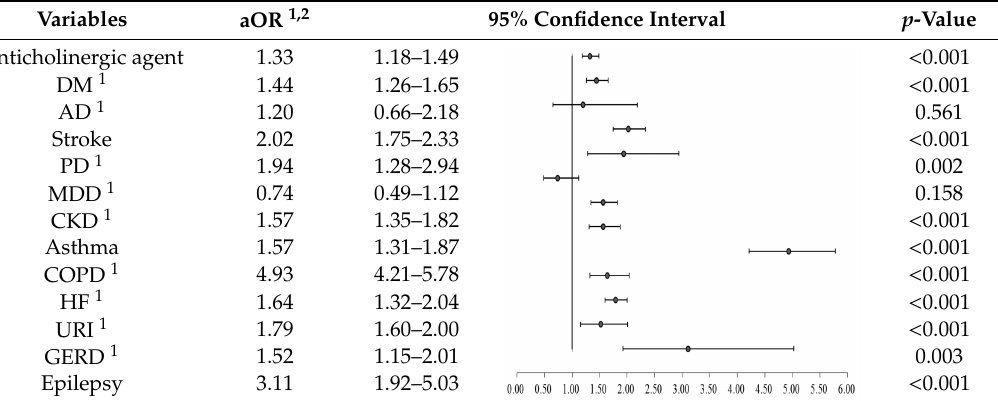
Table 4. Comparing the risk of incident pneumonia between elderly patients with and without anticholinergic drugs.